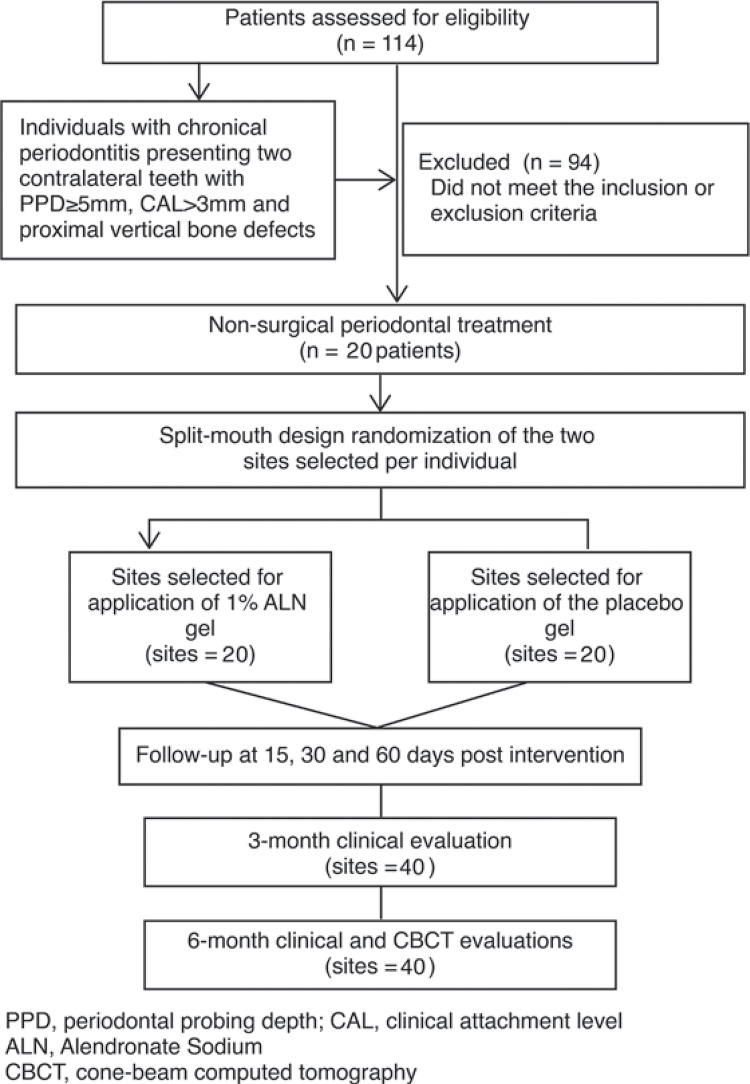
Study of the flowchart